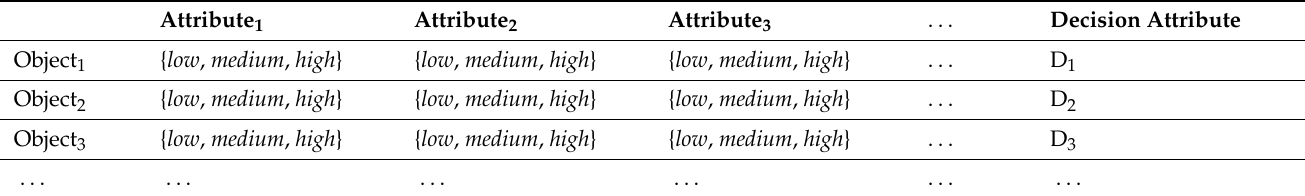
Table 2. A type-1 fuzzy information